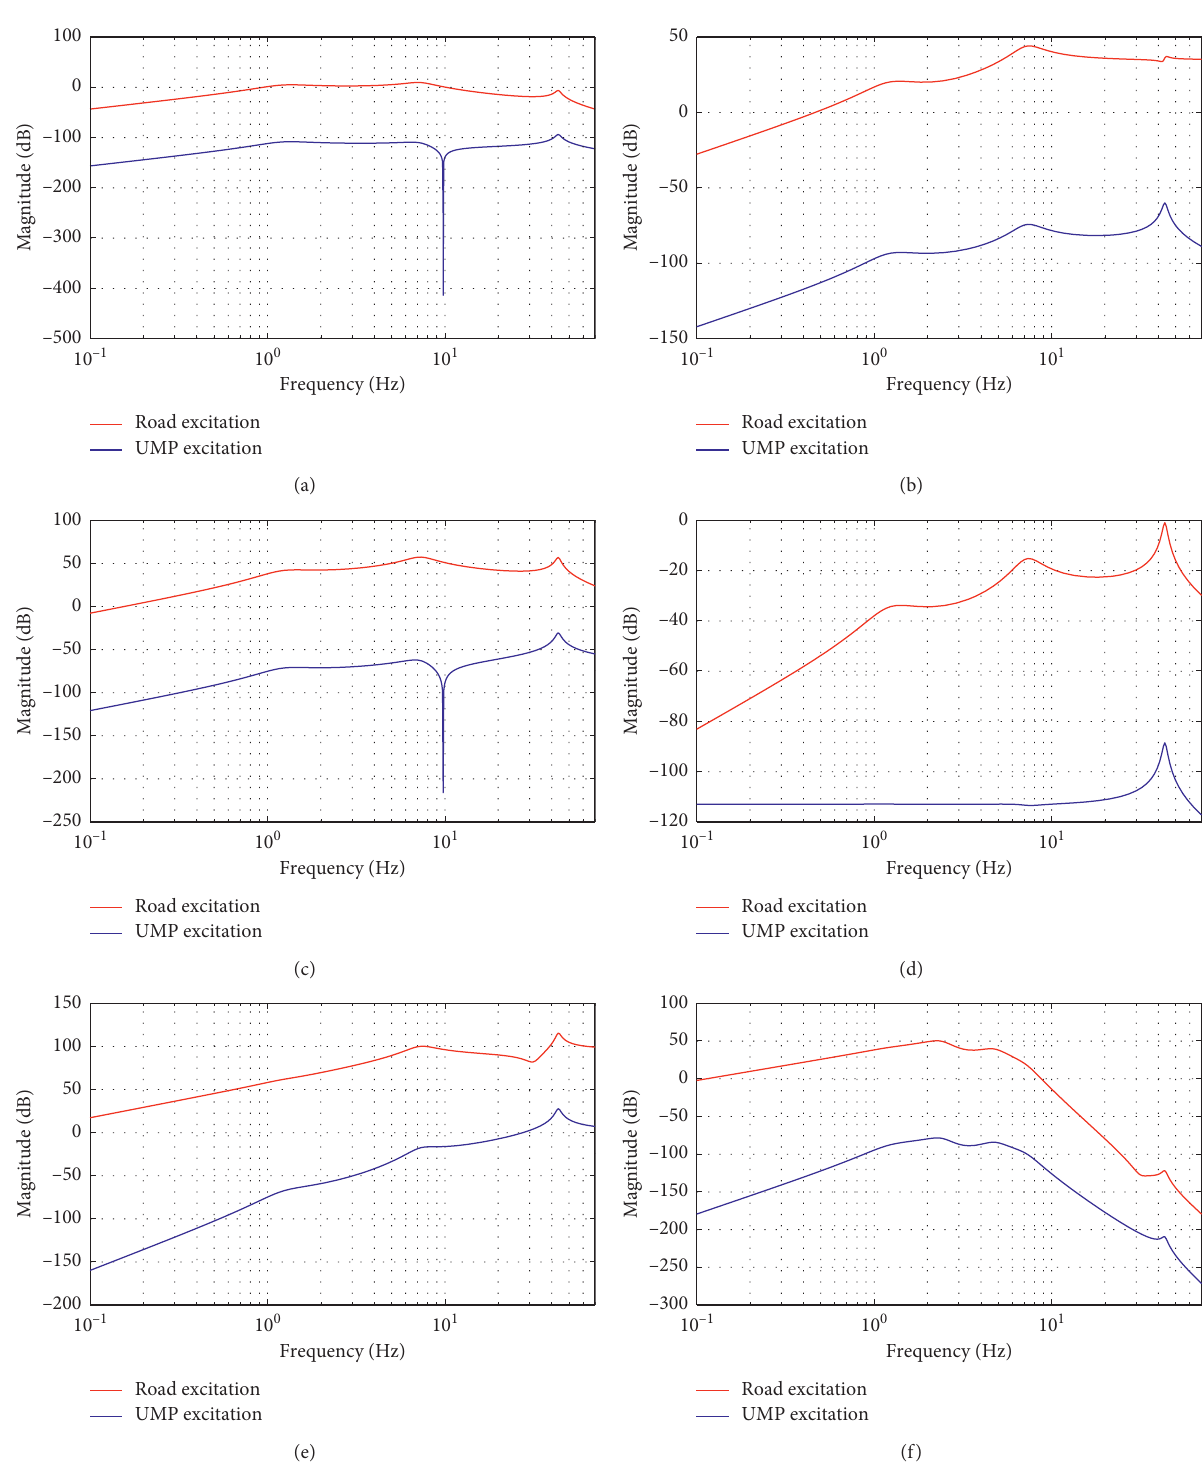
Figure 15: HDD-AS system transmissibility ratios on UMP and road excitation. (a) Suspension deflection. (b) Tire dynamic load. (c) Sprung mass vertical acceleration. (d) Eccentricity. (e) Longitudinal driving force. (f) Motor